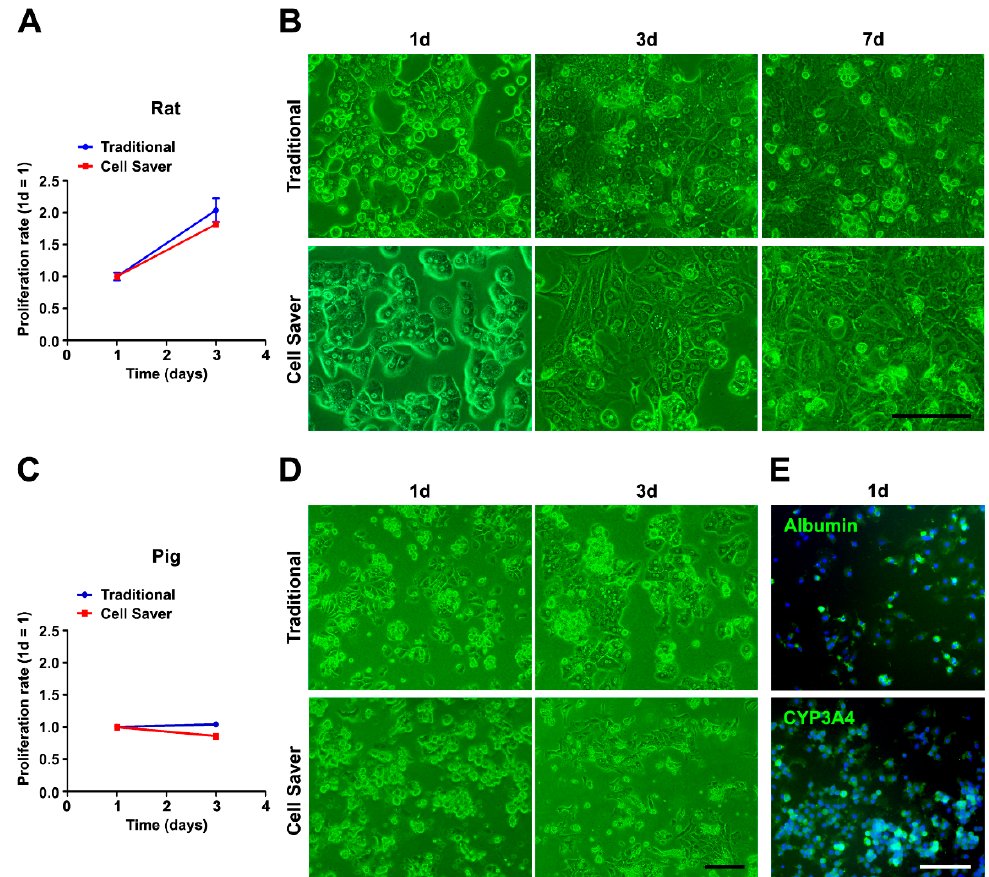
Figure 4. Primary hepatocyte culture, characterization, and cell proliferation assay ( A , B , rat liver cells; C – E , pig liver cells). ( B , D ) Morphology of hepatocyte colony was observed using either the traditional method or Cell Saver ® strategy. ( A , C ) Cell proliferation of isolated liver cells measured through water soluble tetrazolium-1 (WST-1) colorimetric assay was similar between the two strategies. ( E ) Isolated hepatocytes obtained using the Cell Saver ® strategy were confirmed based on albumin and cytochrome P450 3A4 (CYP3A4) expression. Scale bar: 100 μ m.